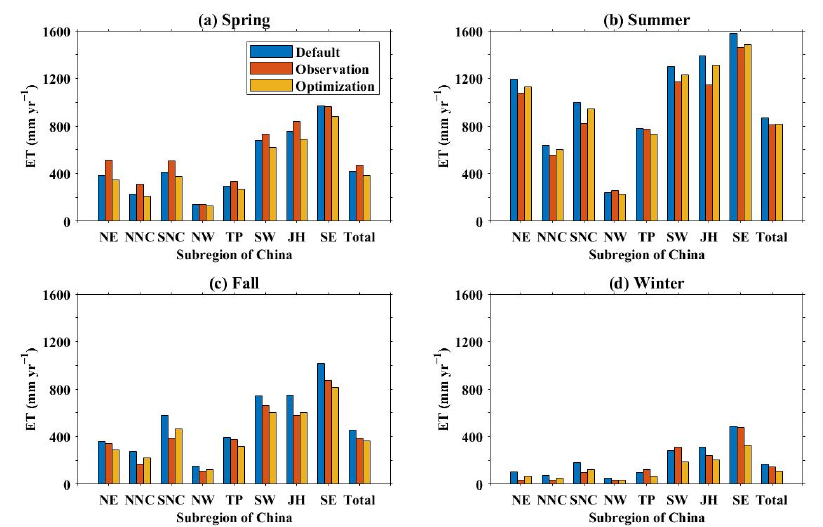
Figure 8. Comparisons of the evapotranspiration at the seasonal scale among default simulations, optimal simulations, and observations for China and its eight subregions for: ( a ) Spring, ( b ) Summer, ( c ) Fall, and ( d )